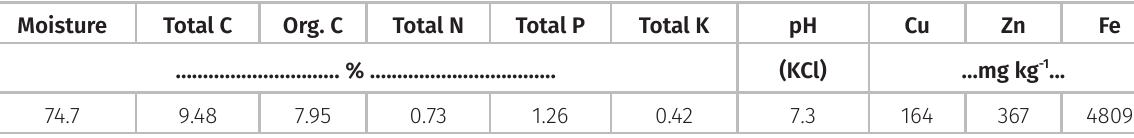
Table II. Moisture and chemical parameters of the swine manure.